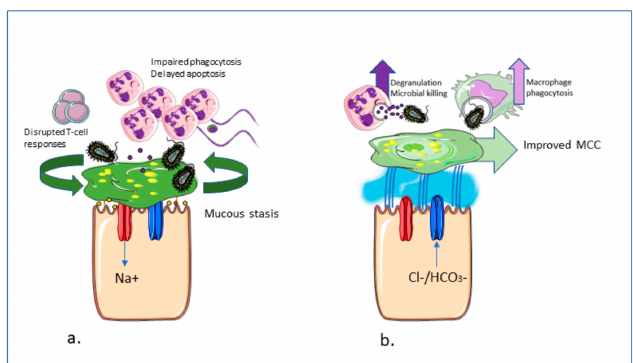
Figure 2. Potential e ff ects of CFTR modulators on inflammation and host responses in cystic fibrosis (CF). ( a ) In CF airways, depleted airway surface liquid (ASL) and poor mucociliary clearance (MCC) leads to mucus adherence to exposed epithelial surfaces. As a result, PWCF have increased susceptibility to, and reduced clearance of, pathogens as well as dysregulated host responses such as impaired neutrophil and macrophage phagocytosis and delayed neutrophil apoptosis. ( b ) With CFTR modulator therapy, restoration of the ASL barrier may be associated with improved MCC and epithelial